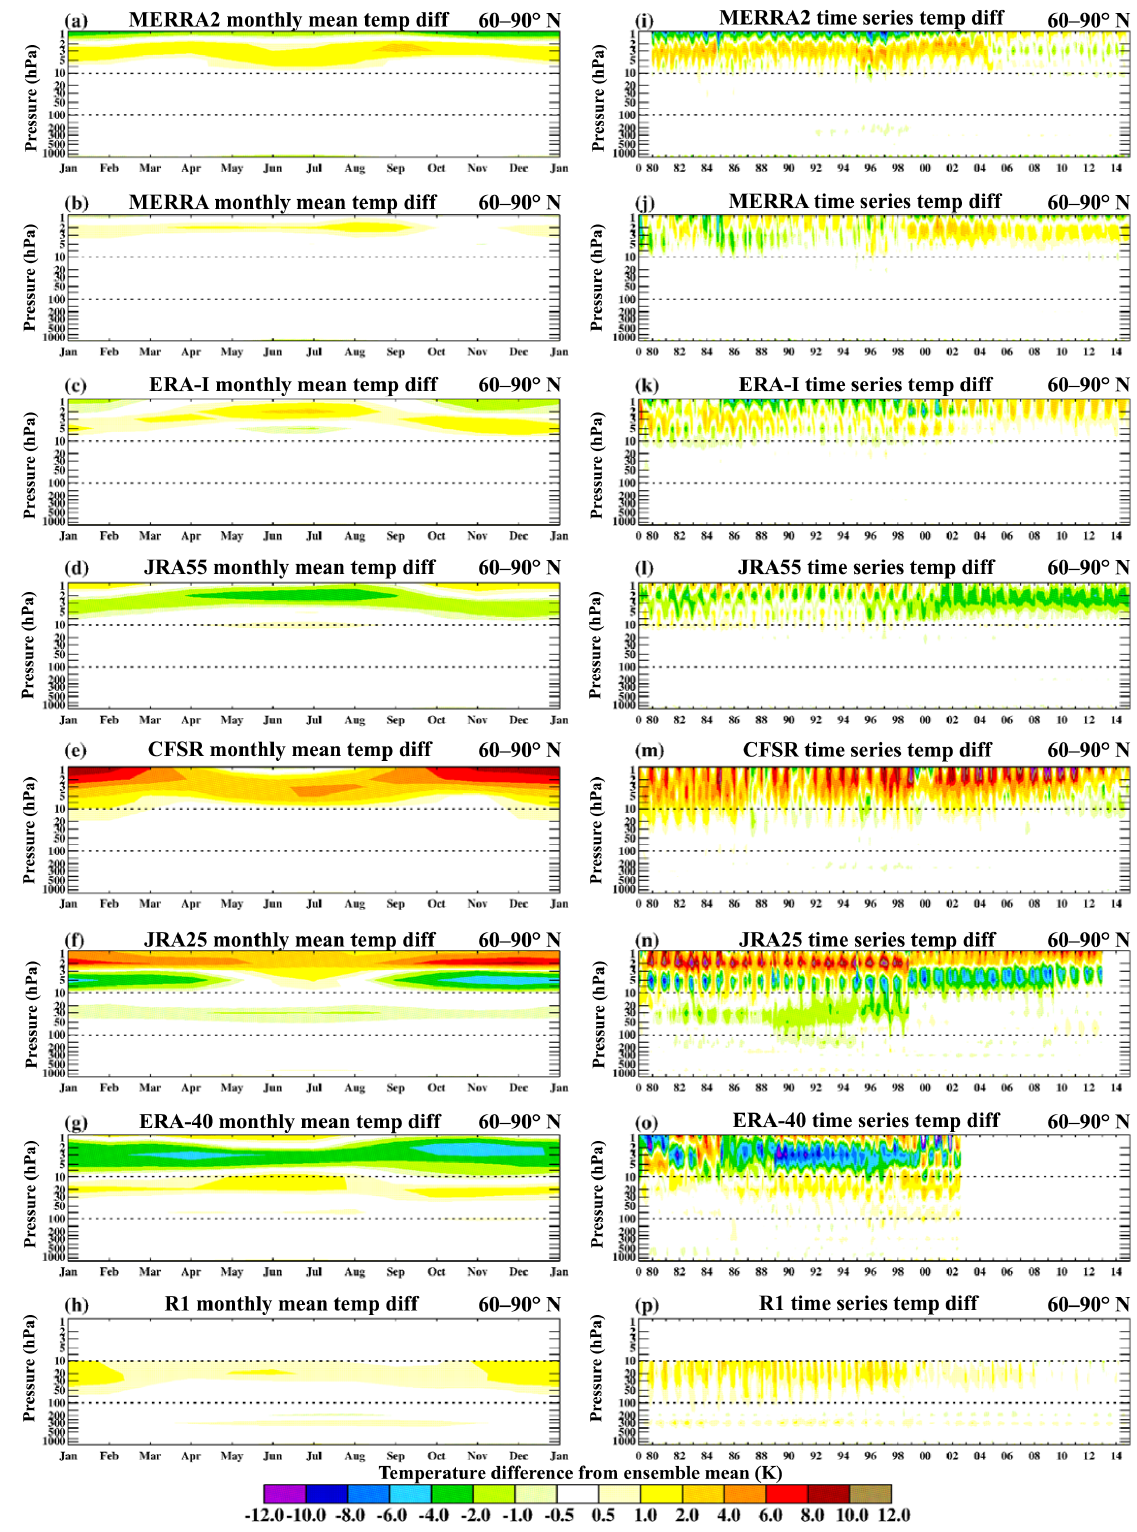
Figure 7. Same as Fig. 6 but for the 60–90 ◦ N latitude